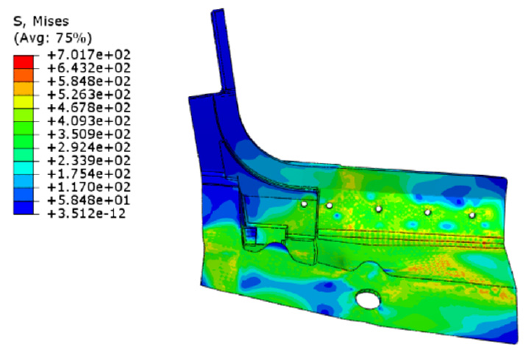
Figure 14. The stress situation of nonlinear buckling. The stress curves of five nodes are extracted from the bearing surface area, and the node position is shown in Figure 15. The stress curves of nodes A to E are shown in Figure 16. Before reaching the critical load, the stress amplitude of nodes A, B, and C rises rapidly, and then, the stress level of the three points remains roughly unchanged. The stress of node E and node D increases with the load, and the stress at node D rises faster. However, when the load reaches the critical load, the stress levels of nodes E and D are smaller than those of nodes A, B, and C. From the results of stress analysis, when optimizing the structural strength, the structural strength of nodes A, B, and C should be considered emphatically, which improves the strength of the outer edge of the bearing area, as shown in Figure